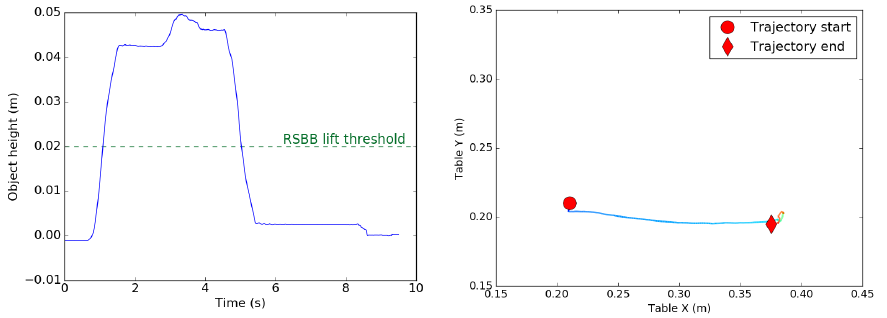
Figure 20. A Pick and Place attempt captured by the RSBB system. Left: Variation in the object’s height relative to the table, describing a successful picking. Right: X, Y trajectory of the object on the table, showing a correct re-positioning of the object to the target